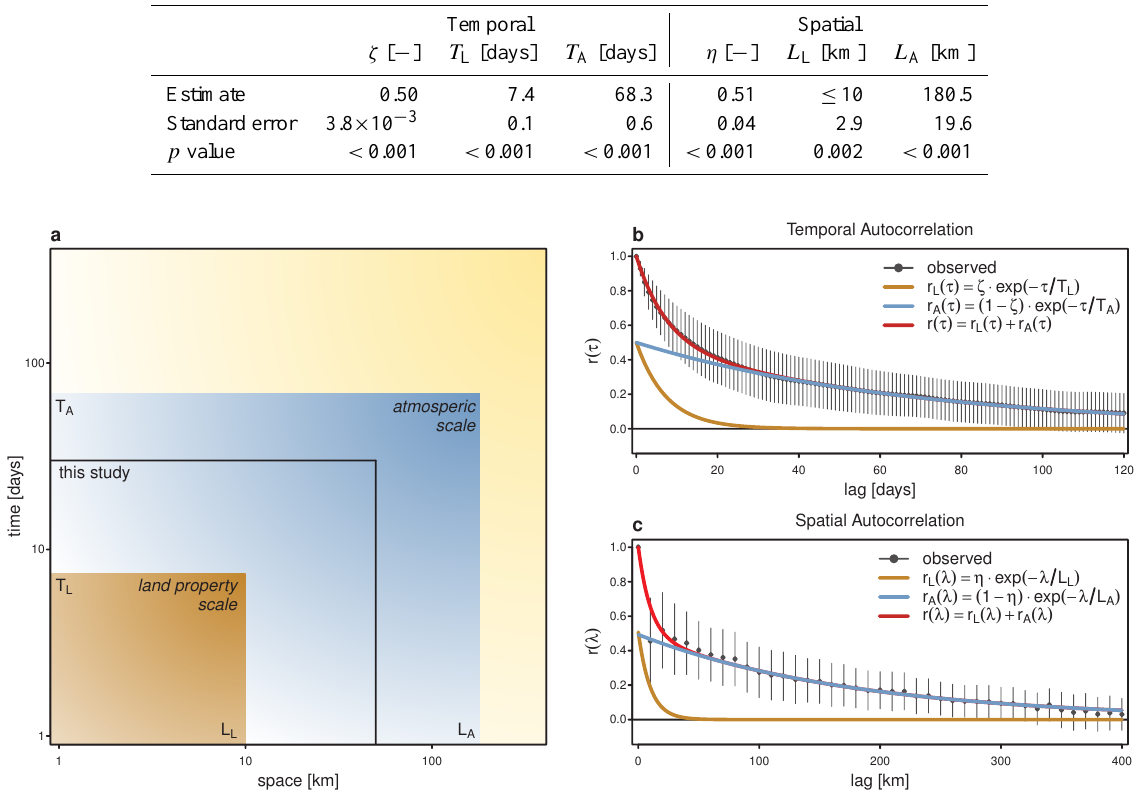
Figure 14. Time- and space scales of runoff in Europe. (a) Empirical results suggest that runoff in Europe has two space scales and timescales. A small scale ( T L : timescale; L L : space scale), at which runoff dynamics is strongly influenced by locally varying land properties, and a large scale ( T A : timescale; L A : space scale) at which runoff dynamics is dominated by atmospheric forcing. Both the spatial and temporal resolution of this study are located well above the scales at which land properties are expected to have a strong influence on runoff dynamics. (b, c) Small and large scales are estimated from observed autocorrelations of daily runoff anomalies in Europe. Vertical bars denote the standard deviation of the observed autocorrelation. See text for